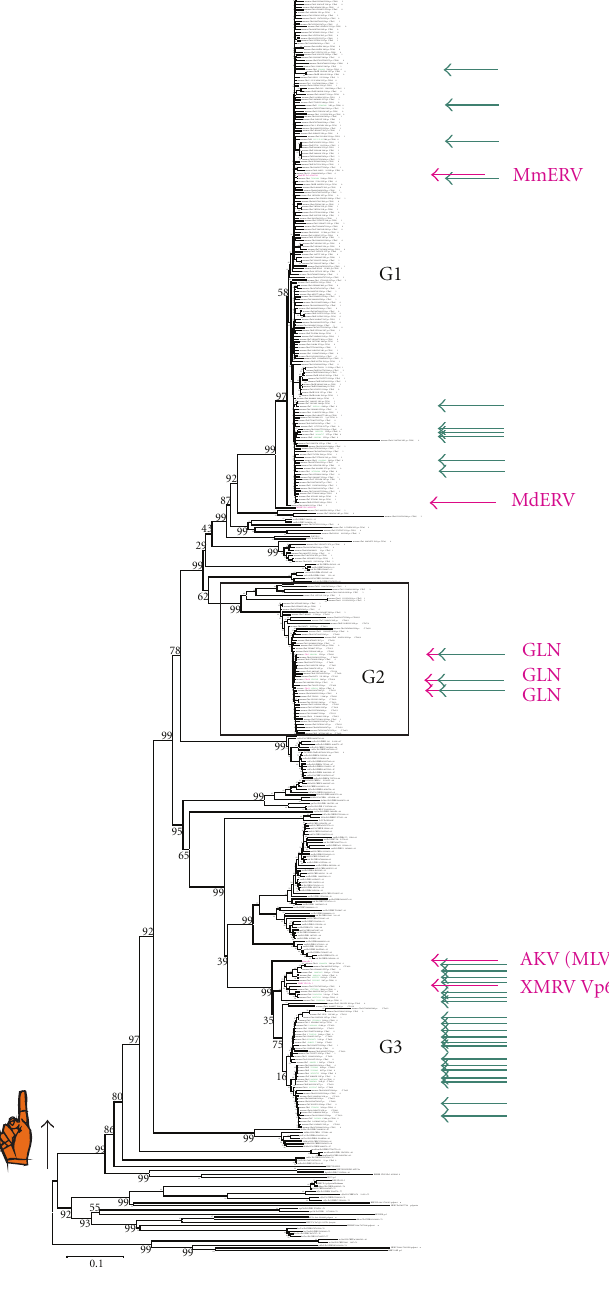
Figure 3: Neighbor-joining (NJ) tree based on Pol amino acid sequences of 300 high ReTe scoring MLLVs, the same as in Figure 4. The three high-scoring murine gamma groups (G1–G3) segregate in a similar way as in a gag nt-based tree (Figure 4). Bootstrap values are shown to the left of each branch. Structurally intact proviruses are marked with green arrows. GLN virus [15], MmERV, Mus dunni ERV (MdERV), AKV MLV, and XMRV (VP62 clone) are marked with magenta arrows. Murine MLLVs occur from the black arrow in the tree and upwards. The branch labels are either ERV host genus, chromosomal position, ReTe score, provisional genus, “po” for Pol, PBS, and number of stops and frame shifts (“z 0/0” means 0 stops and 0 shifts in pol ), or a reference Pol name. PBS assignments are made by the 1.01 version of RetroTector. A more complete interpretation of PBS sequences of the G1-G3 groups is given in a forthcoming publication (Elfaitouri et al., accepted in Plos One). The major one zinc finger branch is indicated by the hand symbol. Nonmurine gammaretroviral ERV sequences were taken from the prototype of RetroBank. Further information on which assemblies were used can be found in